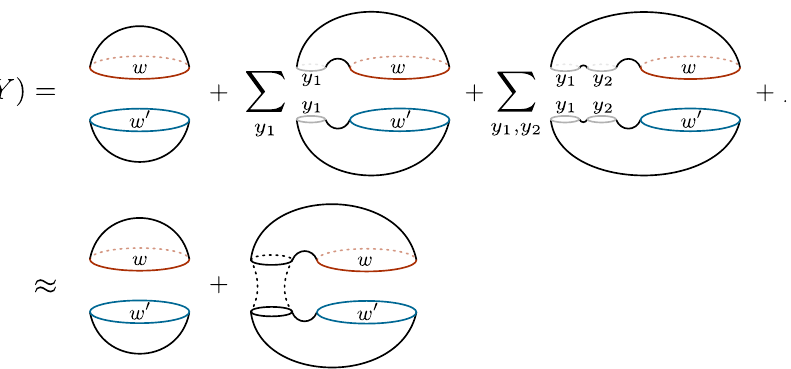
p w , w 1 q in (12) with ρ “ ρ Figure 2: Representation of ρ . Recall that Y is not 1-univ HH necessarily connected. For an appropriate choice of state and model, the sum over Y can give rise to an approximate “effective" wormhole between w and w 1 [ 28,54 ]